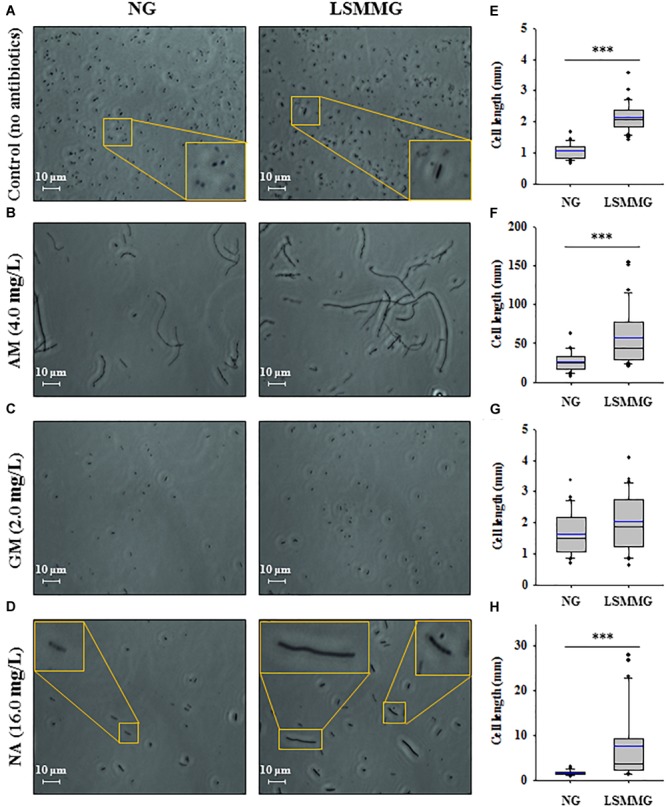
(A–D) The liquid cultures of strain ATCC 43895 in the absence (control) or presence of antibiotics (at 4 × MIC) were centrifuged to concentrate the residual biomass; the wet mount preparations were then analyzed using phase-contrast microscopy. Scale bar: 10 μm. (E–H) Cell lengths in bacterial cultures in (A–D), respectively. The squares indicate the interquartile range for each data point, and the black and blue lines denote the median and mean values, respectively. The error bars above and below the squares indicate the 90th and 10th percentiles, respectively, and the black circles represent the outliers. The asterisks represent significant differences between NG and LSMMG cultures (∗P < 0.05 and ∗∗∗P < 0.001).